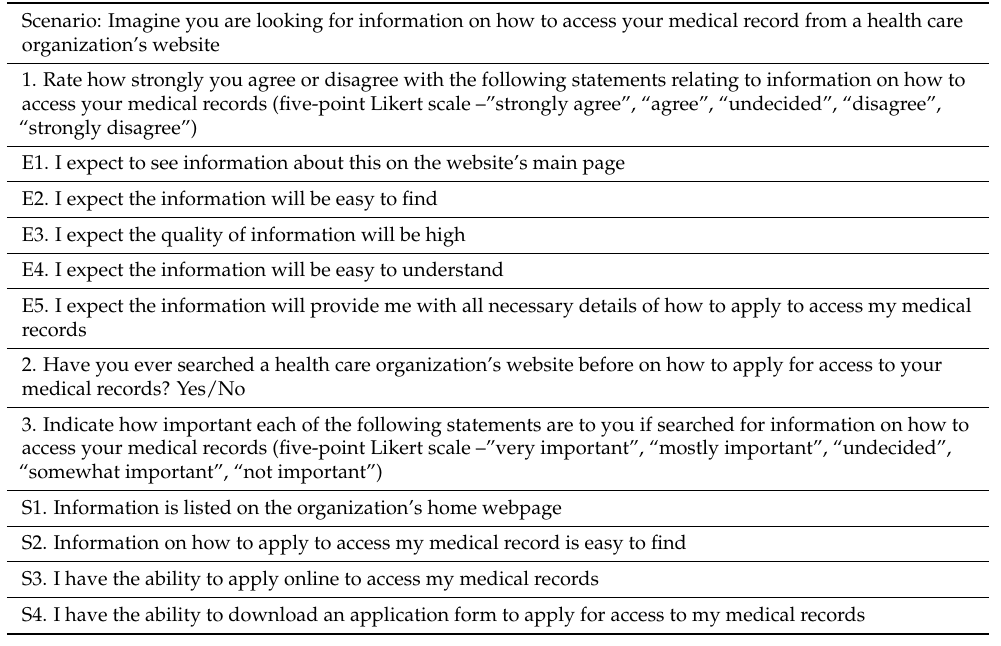
Table 1. Survey questions about expectations of health care organization websites.